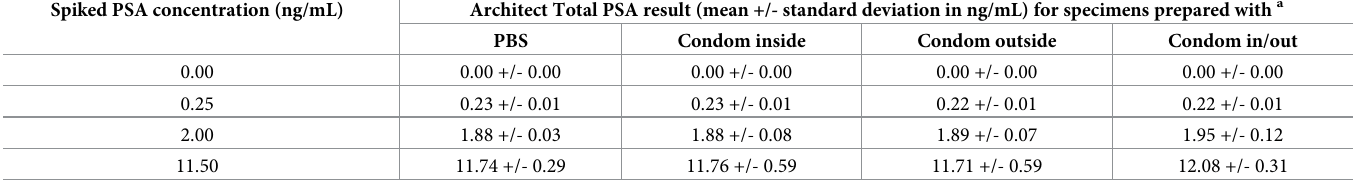
Table 1. Detection of PSA in PBS alone or material extracted from the inside or outside of CSD500 condoms from spiked specimens, by PSA concentrations used for spiking. Spiked PSA concentration